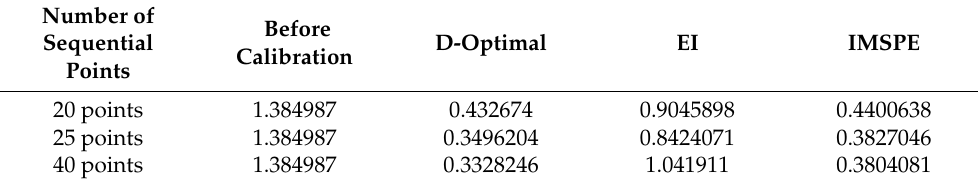
Table 4. MSPE before and after